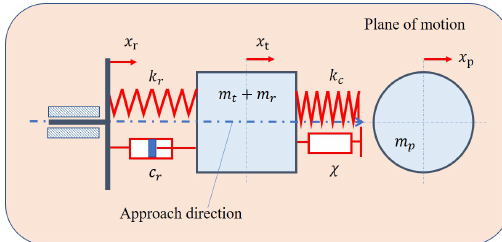
Figure 8. Scheme of the impact between the compliant robot and an